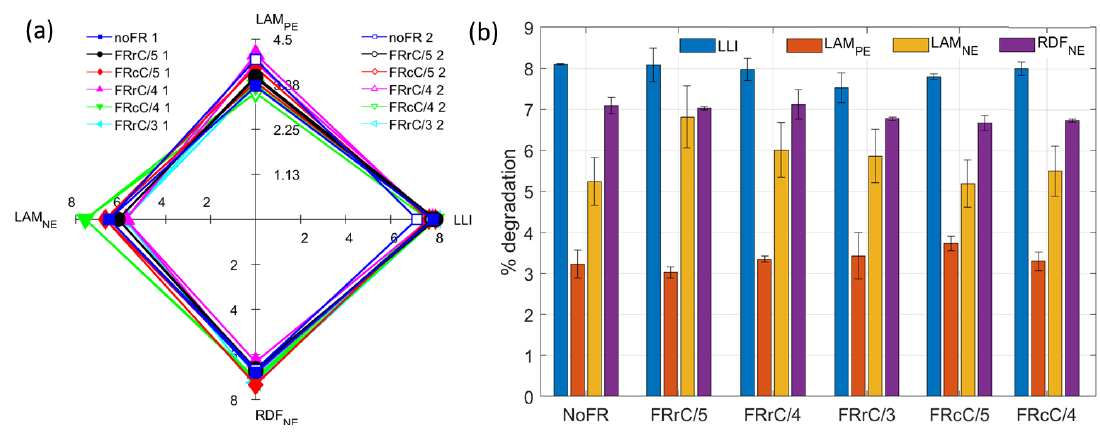
Figure 6. Comparison of experimental and simulated incremental capacity (IC) curves for the NoFR_1 cell ( a ) after 3,000 Ah exchanged and ( b ) at the onset of the second stage.